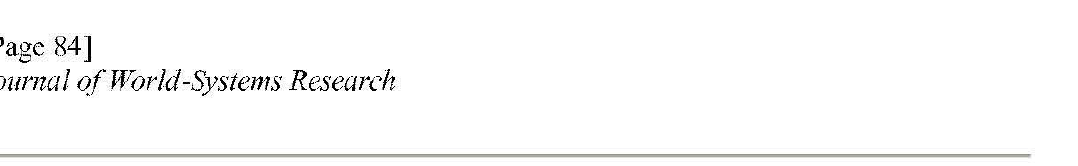
I Country I 1751-1755 I 1786-1790 Austrian Neth. To 450,000 From 89,000 +50 To